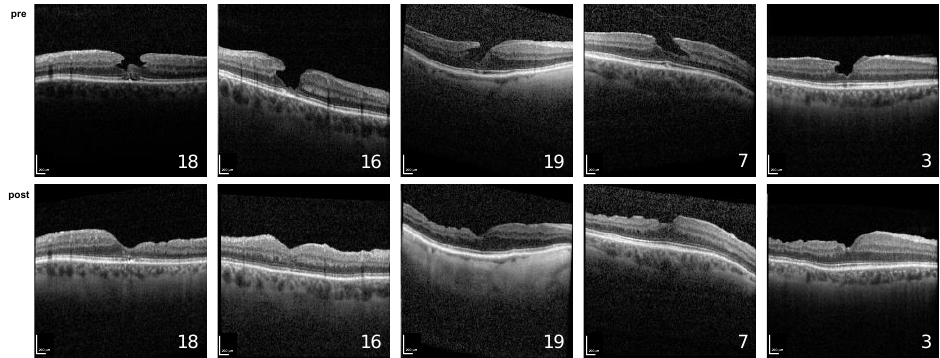
Figure 1. Spectral domain optical coherence tomography of patients (ID 1, 3, 7, 9, and 10) conducted preoperatively ( top ) and at the most recent follow-up ( bottom ); scale bar = 200 µm. Figure 1: Preoperative (up) and after longest follow-up/postoperative (below) spectral-domain optical coherence tomography of patients